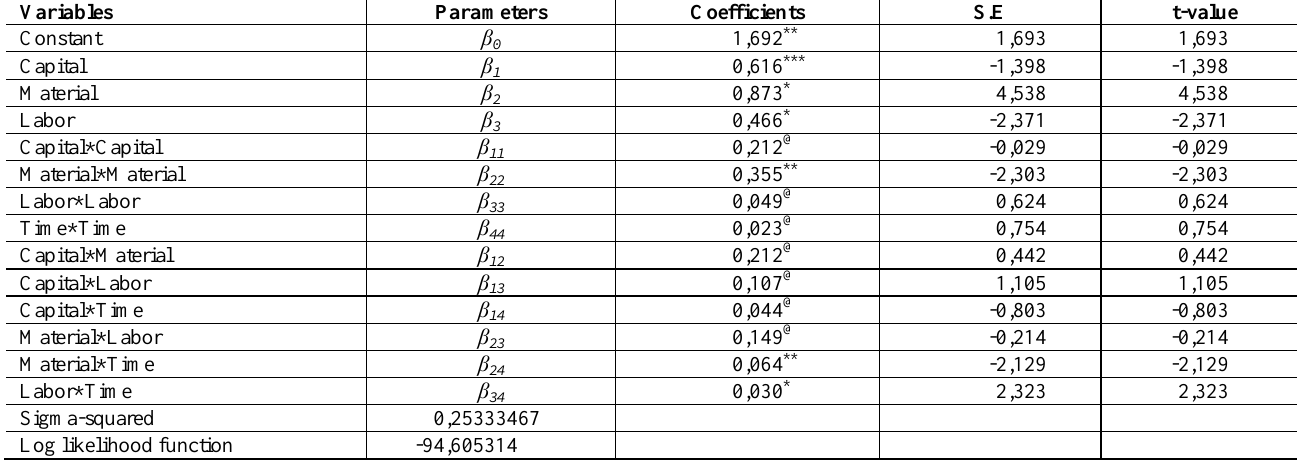
Table 2: OLS estimates of translog stochastic frontier production function: Profits frontier Variables